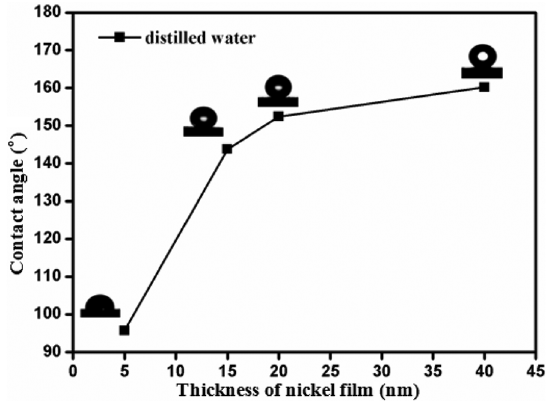
Figure 7: Effect of the nickel film thickness on the contact angle of water on